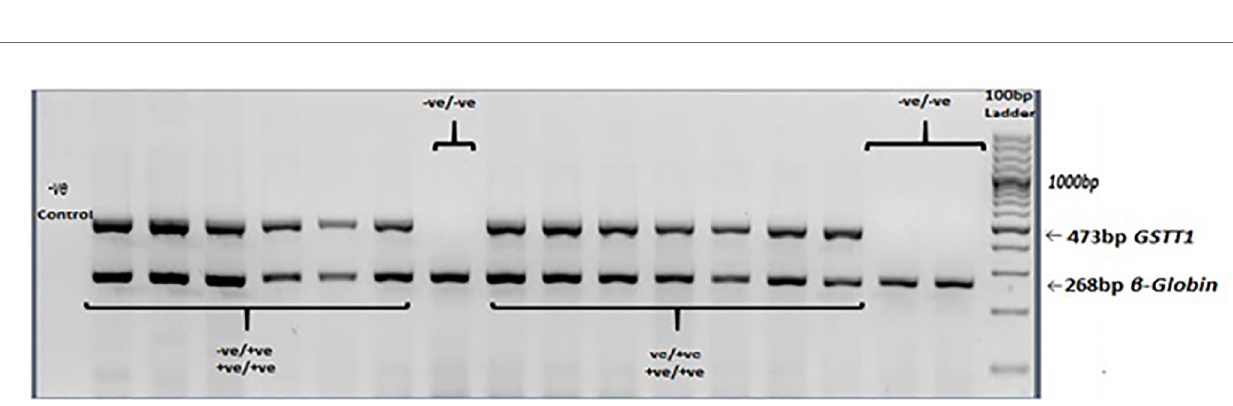
FIGURE 2 | A representative 0.7% agarose gel used for quality control of extracted DNA samples. Lane 1: 100bp DNA ladder; lanes 2-12: